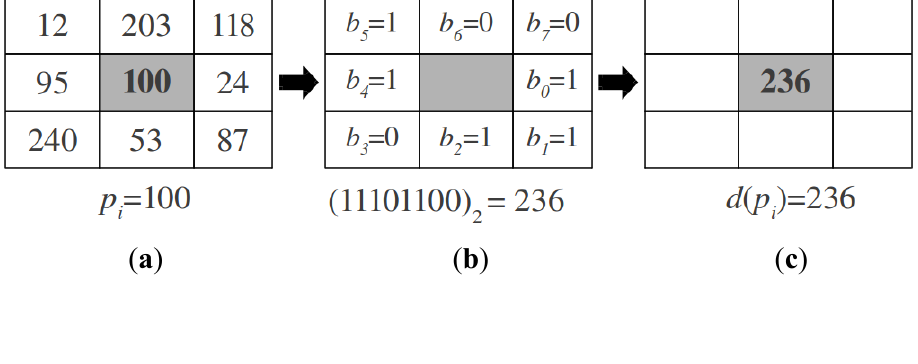
. The values are arranged i with a corresponding decimal 0 in the i